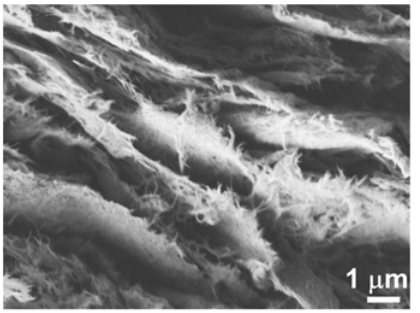
Figure 10. FE-SEM image of freeze-dried cricket nanochitin. Figure 10. FE ‐ SEM image of freeze ‐ dried cricket nanochitin.